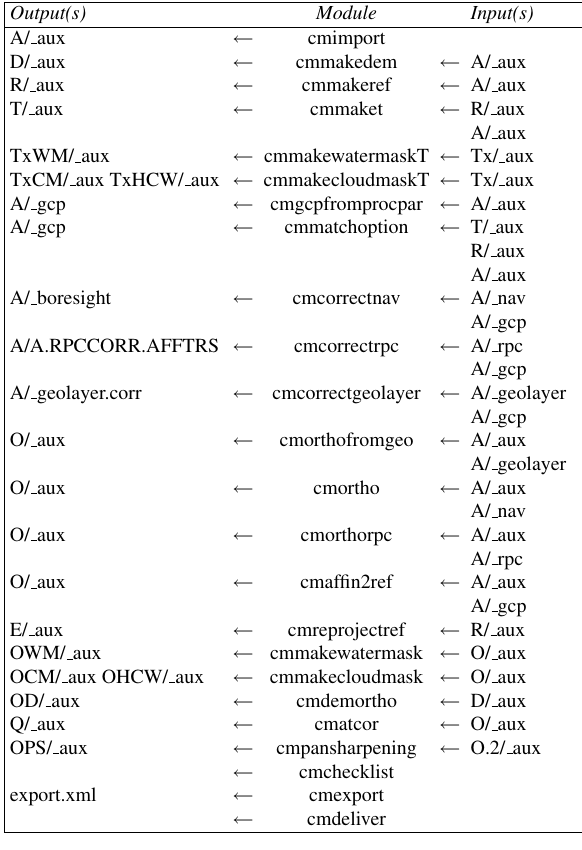
Table 1: Ortho processing Chain-Description; inputs/outputs “A.../ aux” represent XDibias images, all other inputs/outputs represent other files; modules are only executed if one of the de- fined outputs is missing and all of the the required inputs